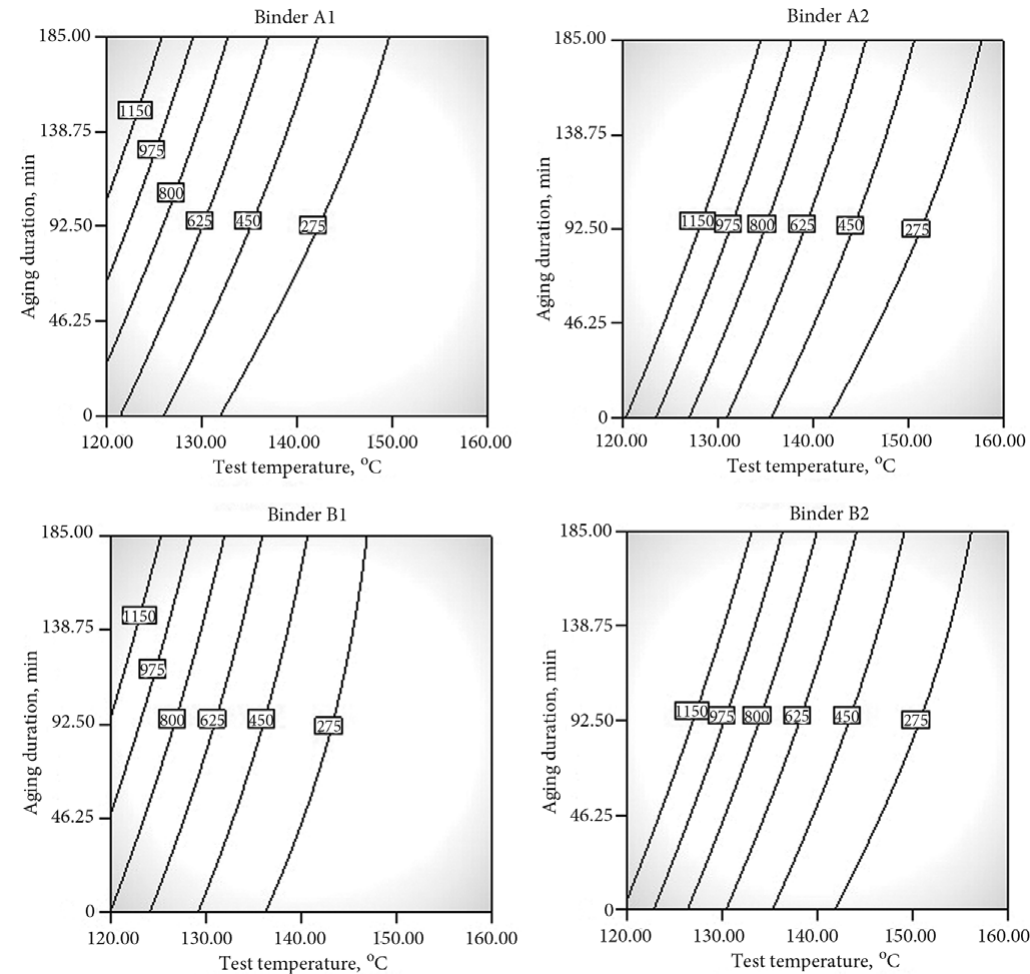
Fig. 1. Binder A1, A2, B1 and B2 viscosity